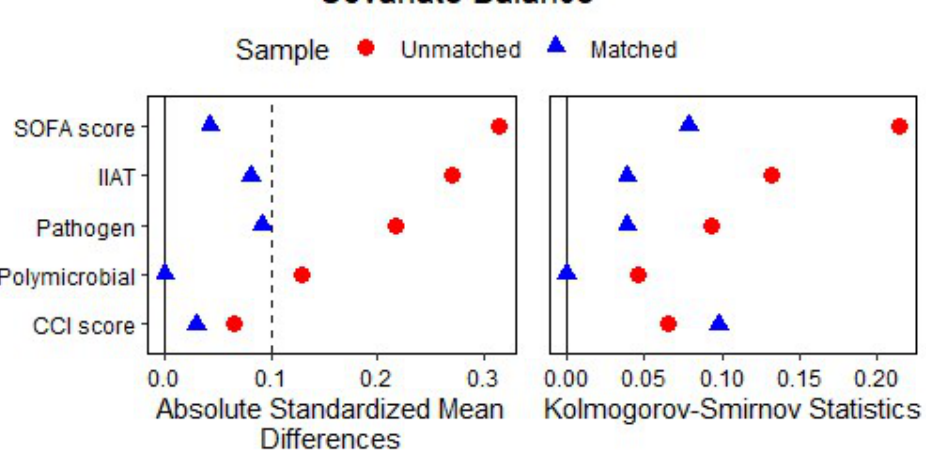
Figure 2. The covariate balance in the two groups before and after the propensity score matching. Red dots and blue triangles indicated the absolute standardized mean differences ( left ) and the Kolmogorov–Smirnov statistics ( right ) of the covariate in the original and the matched cohort, re- spectively. SOFA, Sequential Organ Failure Assessment; IIAT, Inappropriate Initial Antibiotic Ther- apy; CCI score, the age-adjusted Charlson comorbidity index.